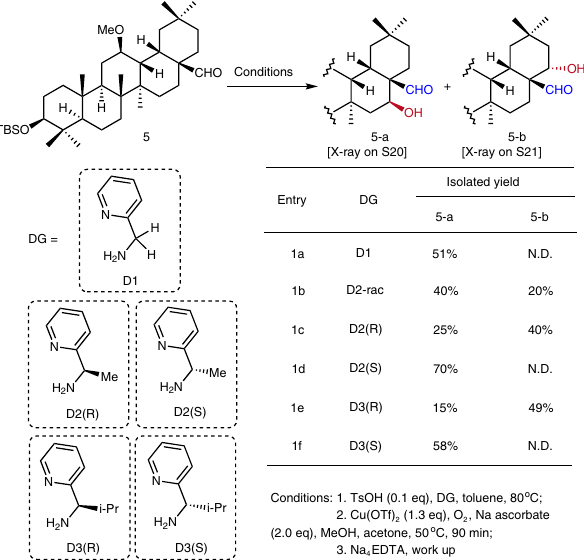
Fig. 2 Site-selective C – H hydroxylation of oleanane C28-aldehyde 5 directed by transient (pyridin-2-ylmethyl)imino groups. i -Pr isopropyl, Me methyl, Na 4 EDTA ethylenediaminetetraacetic acid tetrasodium salt, N.D. not detected. TBS tert -butyldimethylsilyl, Tf tri fl uoromethanesulfonyl, Ts p